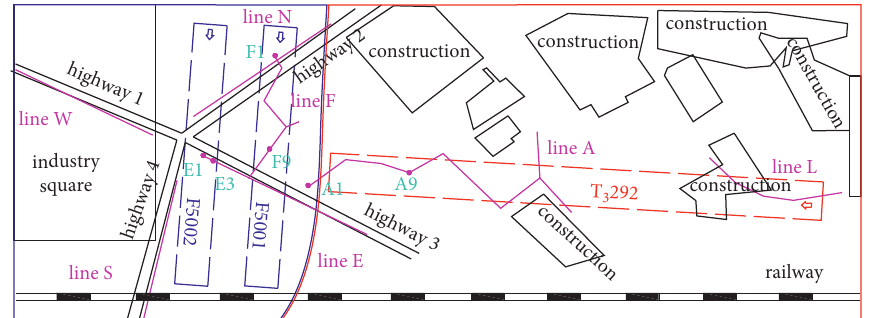
Figure 3: Arrangement of surface deformation observation points on solid backfill mining faces.